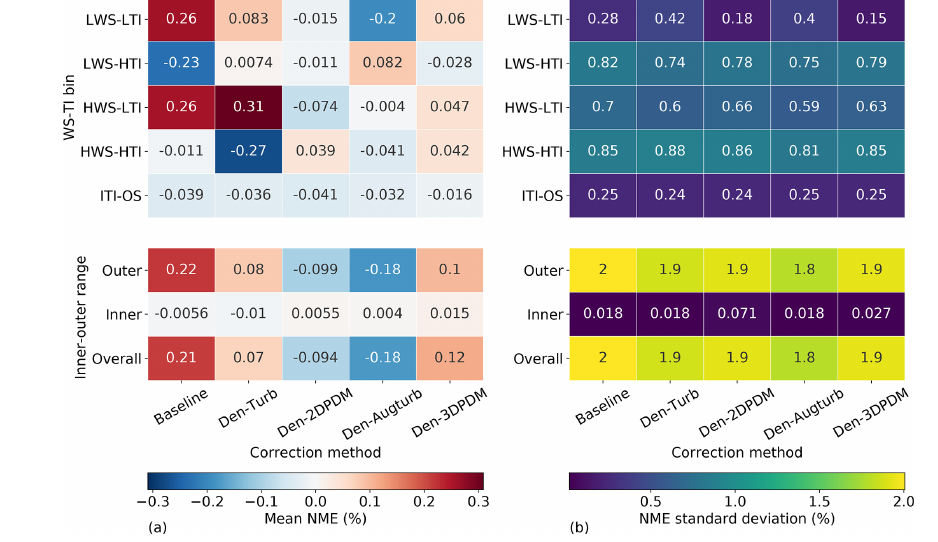
Figure 8. (a) Heat map of mean NME based on 48 submissions across the four WS-TI bins and the ITI-OS bin in the outer range, along with the inner and outer ranges, for five correction methods; blue is negative and red is positive. (b) Heat map of NME standard deviation using 48 submissions across WS-TI and inner–outer range bins and correction methods. The annotated number in each cell represents the mean NME or the NME standard deviation of a specific set of data bin and correction